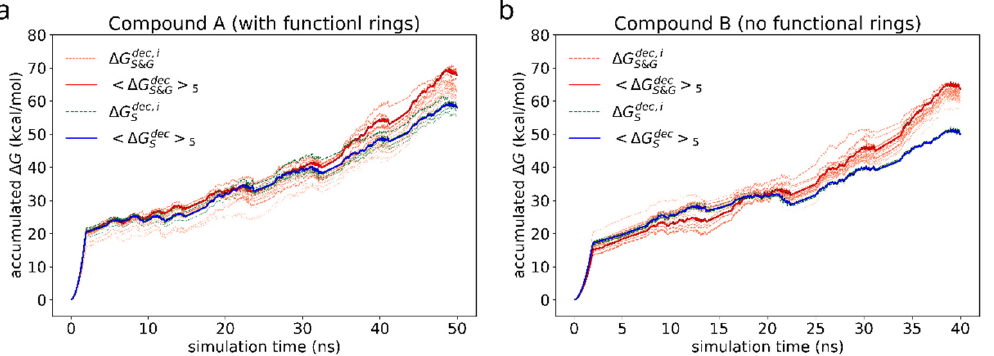
Figure 7. Accumulated free energy change during decoupling of the solvated (green dashed lines) and adsorbed (orange dotted lines) compound dimers. The intensity of the color highlights how close the free energy change of a particular simulation is to the maximum value over the whole set. Blue and red solid lines represent the average of N = 5 most favorable simulations for the cases of solvated and adsorbed dimers correspondingly.